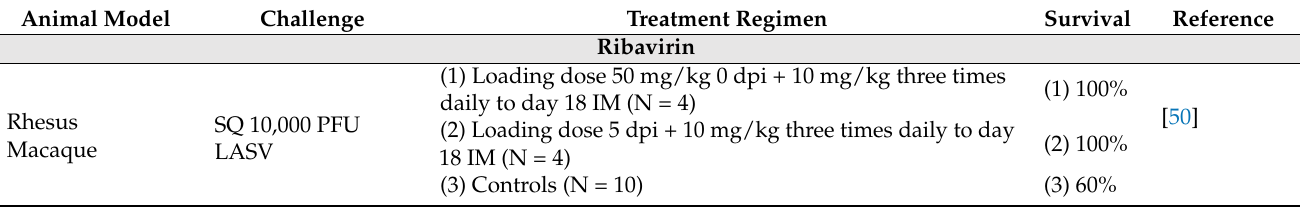
Table 1. Pharmaceutical based therapeutics for Lassa virus (LASV) in non-human primates (NHP) models. Animal